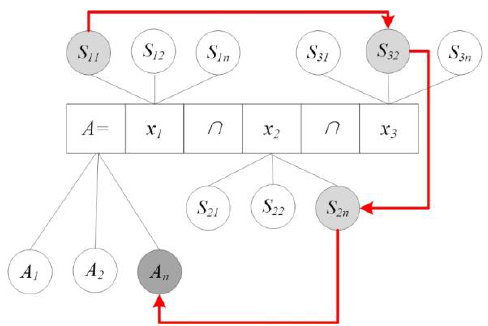
Figure 6. Relationship among addresses, address elements and address semantics.